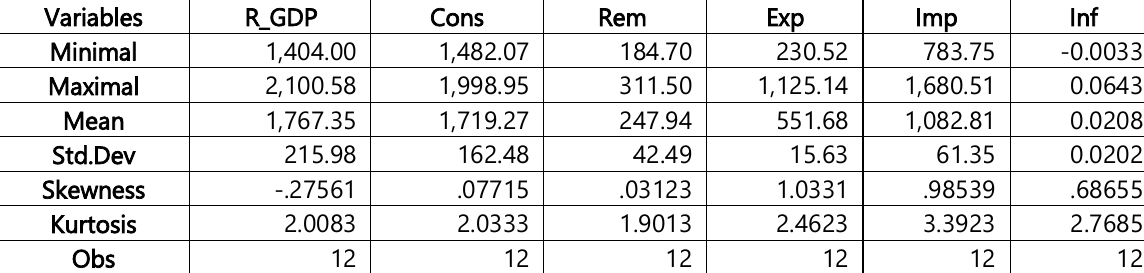
Table 2: Summary of Descriptive Statistics (Source: Authors‘ calculation) Variables R_GDP Cons Rem Exp Imp